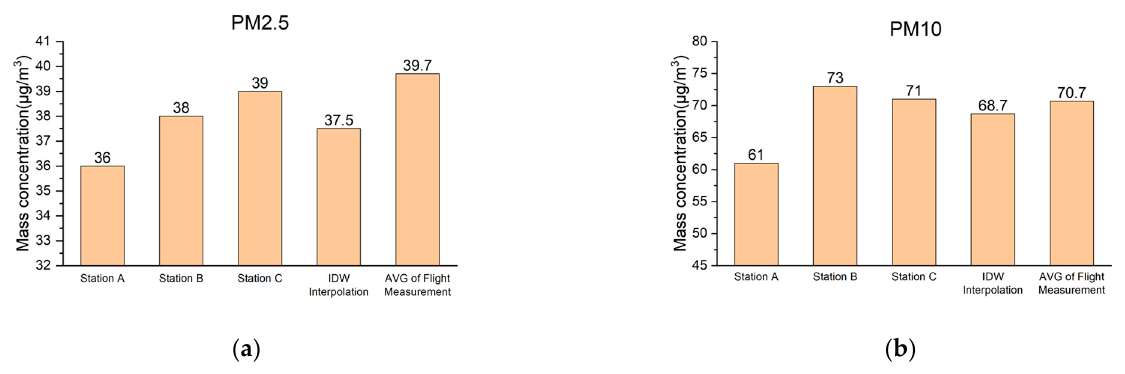
Figure 16. Comparison of spatial interpolation of PM concentration with flight measurement: ( a ) PM2.5; ( b ) PM10.